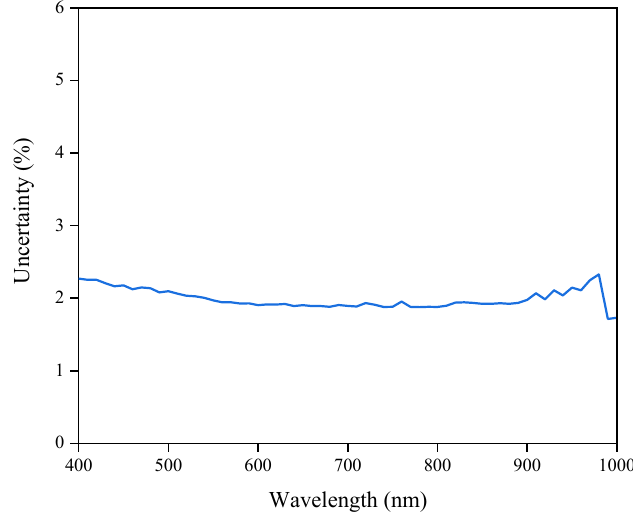
Figure 12. The uncertainty of the surface BRDF characteristics covering 400 nm to 1000 nm for the desert calibration target.